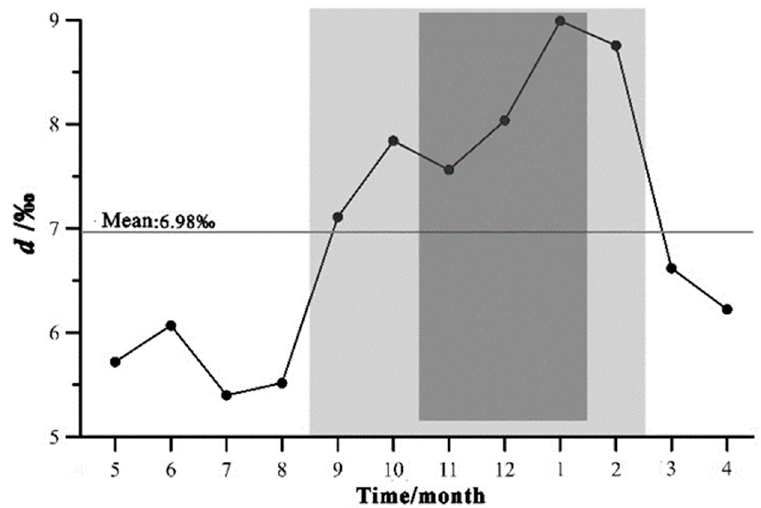
Figure 5. Variation in the deuterium excess of groundwater with time in the study area.